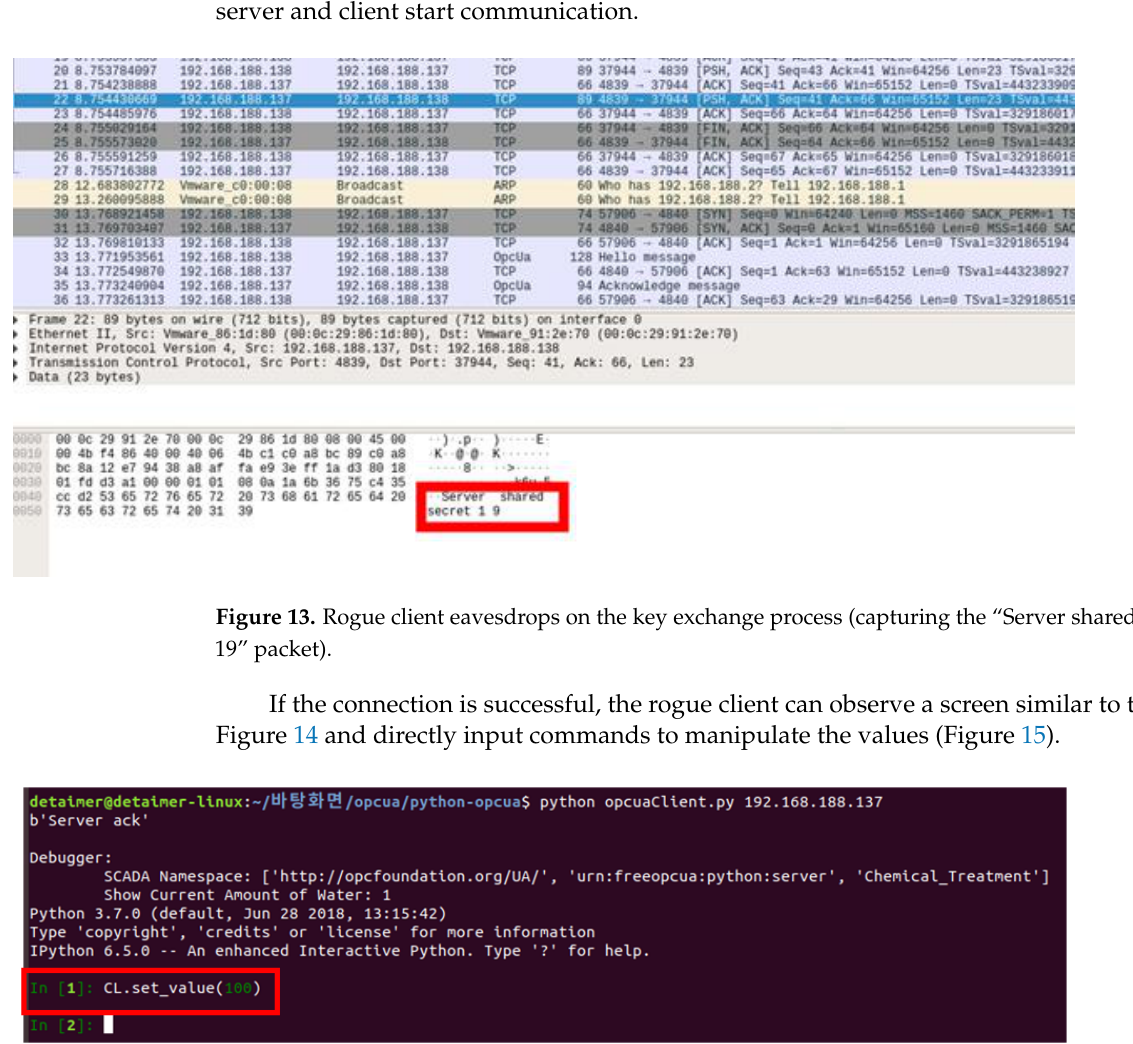
Figure 14. Rogue client manipulates values (normal value: 10; manipulated value: 100).